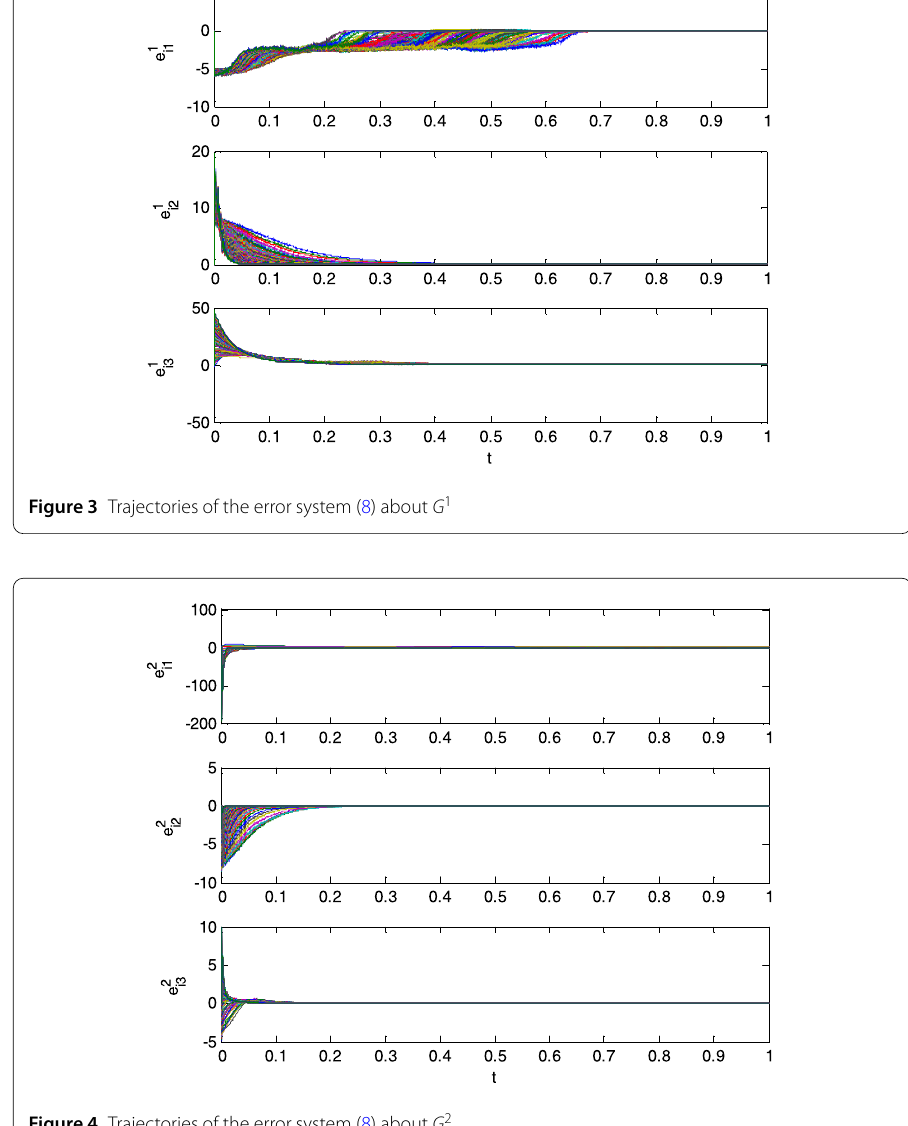
works not only have the intra-coupling connections but also have the inter-coupling de- pendence with each other. Compared with Refs. [13, 14], stochastic disturbances exist our networks. Based on the stochastic Lyapunov stability theory, adaptive control, the Itô formula and the linear matrix inequality, some sufficient conditions are given to en- sure the mean-square heterogeneous asymptotical synchronization for the interdepen- dent networks. Finally, some illustrative examples are given to verify the accuracy and effectiveness of the proposed theory. Simulations show that the given results in this pa- per perform very well. The results and understandings of this paper can be instructive for protecting or building more realistic interdependent networks, such as electric-calculator networks and aviation-railway-road networks with stochastic disturbances. It also can be used to deal with the problems of networks of